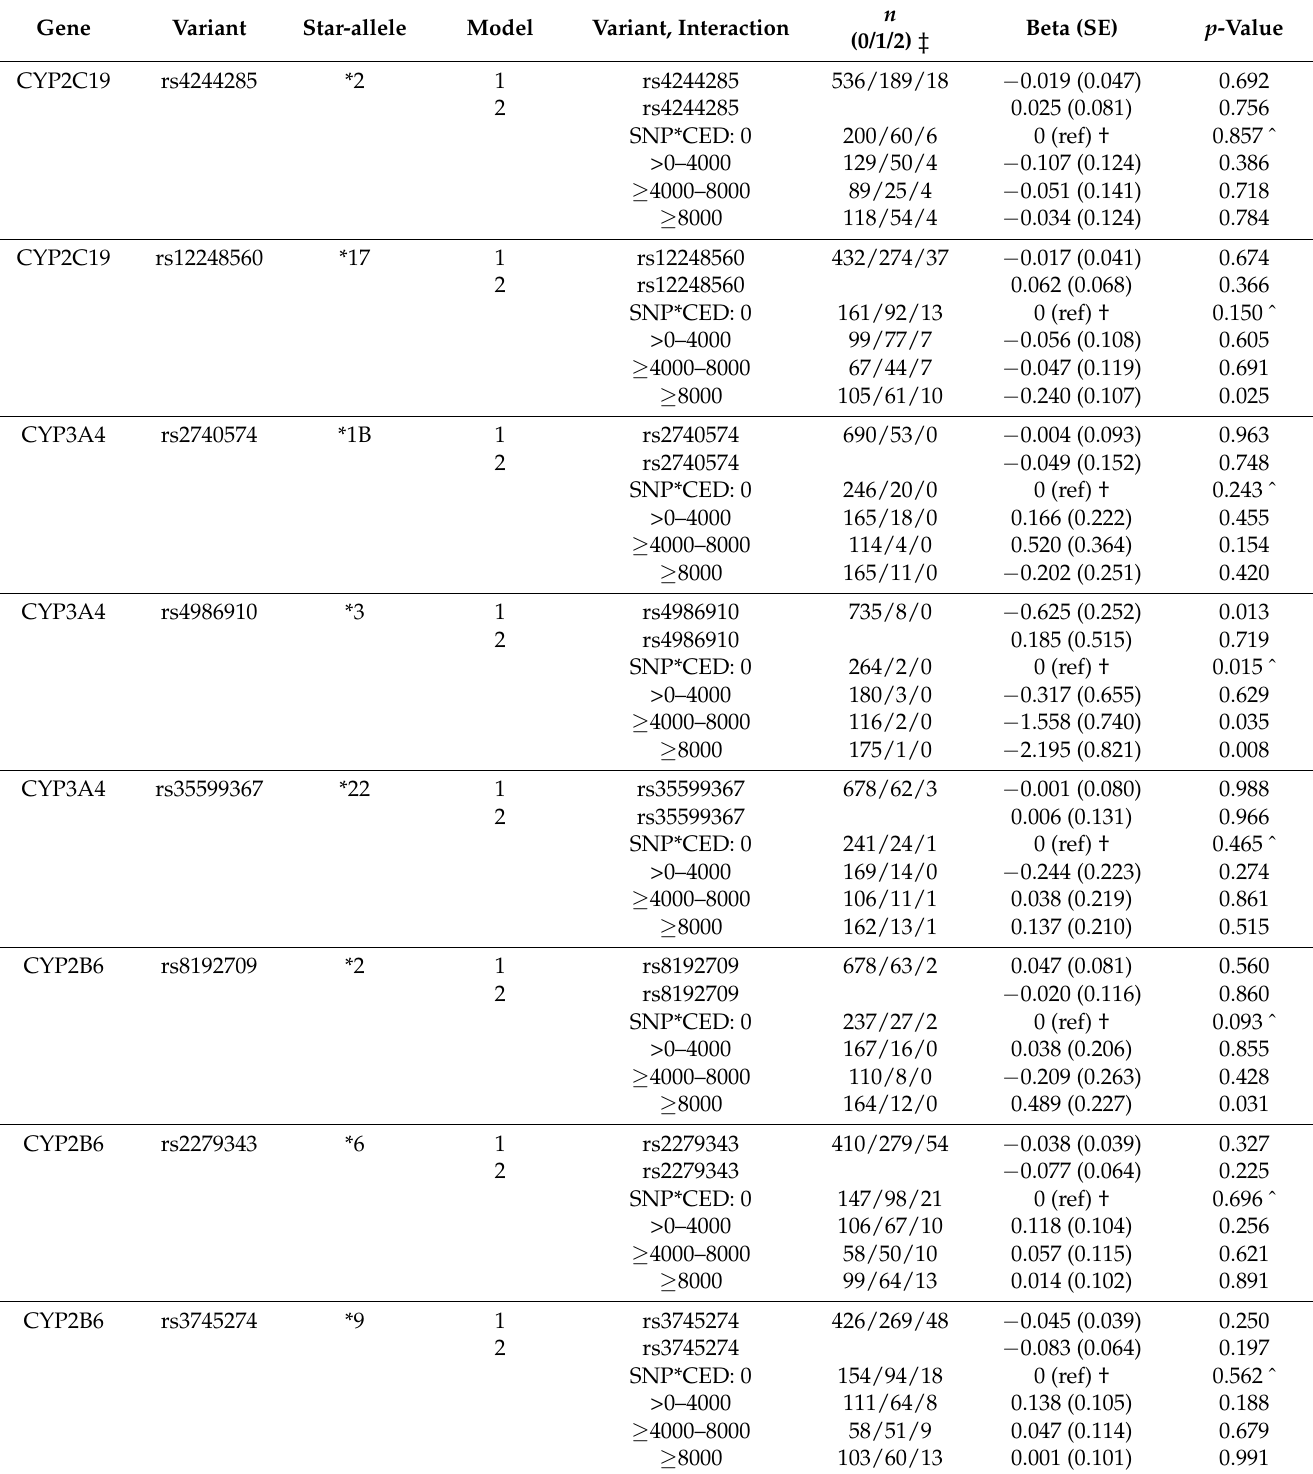
Table 2. Results of the linear regression based on log-transformed AMH and interaction in the Discovery cohort PanCareLIFE. Gene